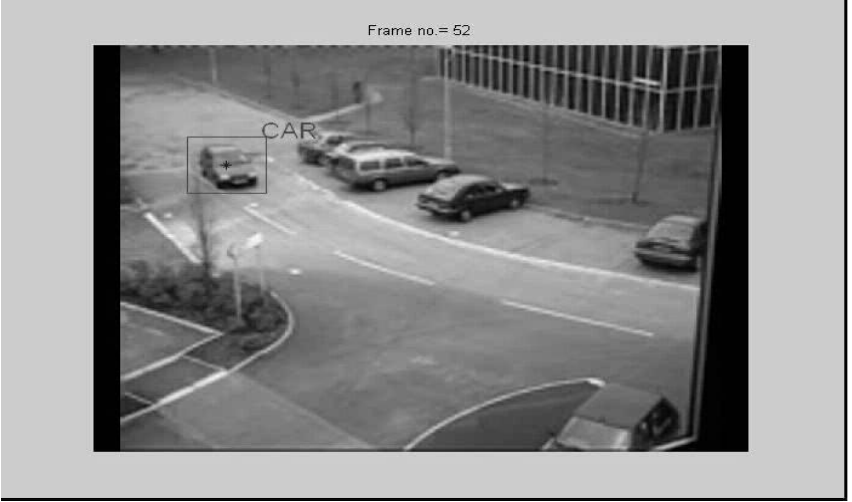
Figure 14. Recognizing object as car.